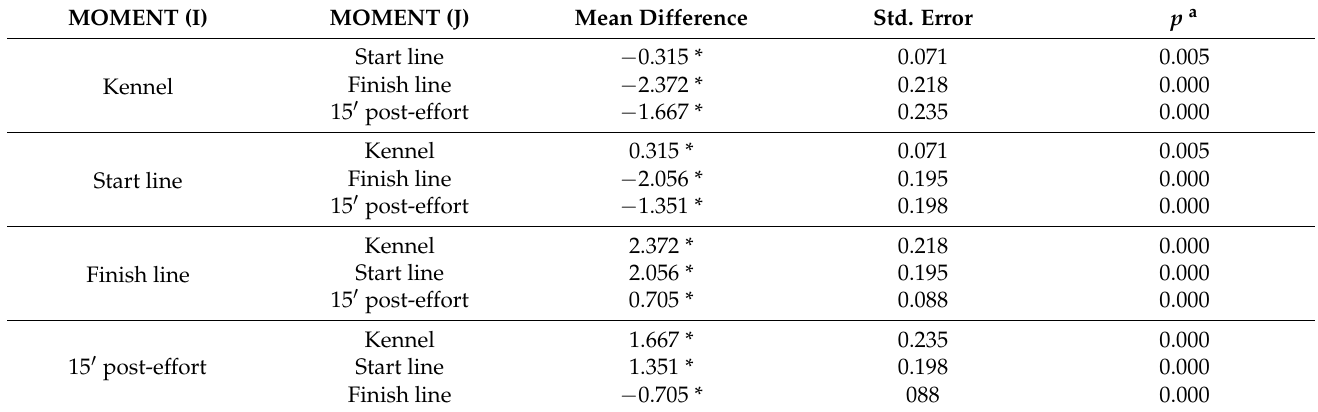
Table 7. Pairwise comparisons for the MOMENT factor. Measure: temperature.